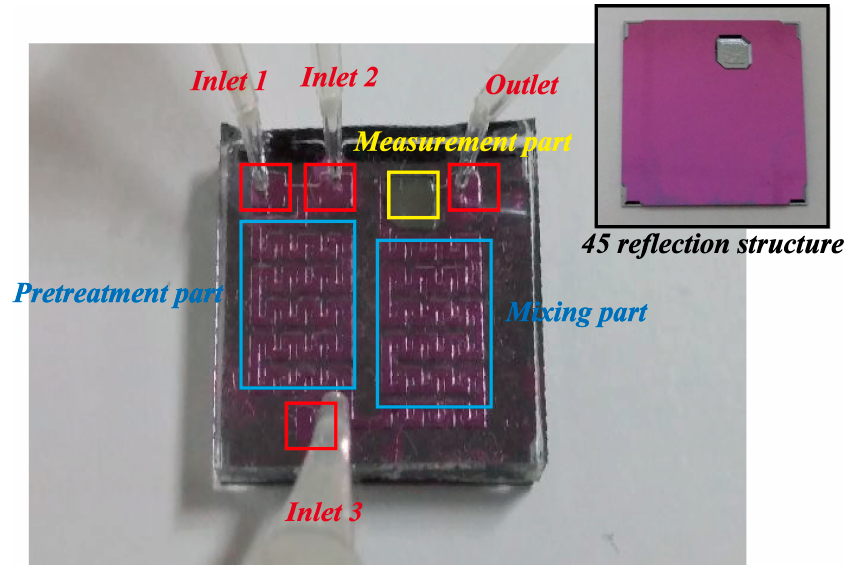
Figure 6. Image of fabricated LOC-based non-invasive optical sensor for measuring glucose in saliva.